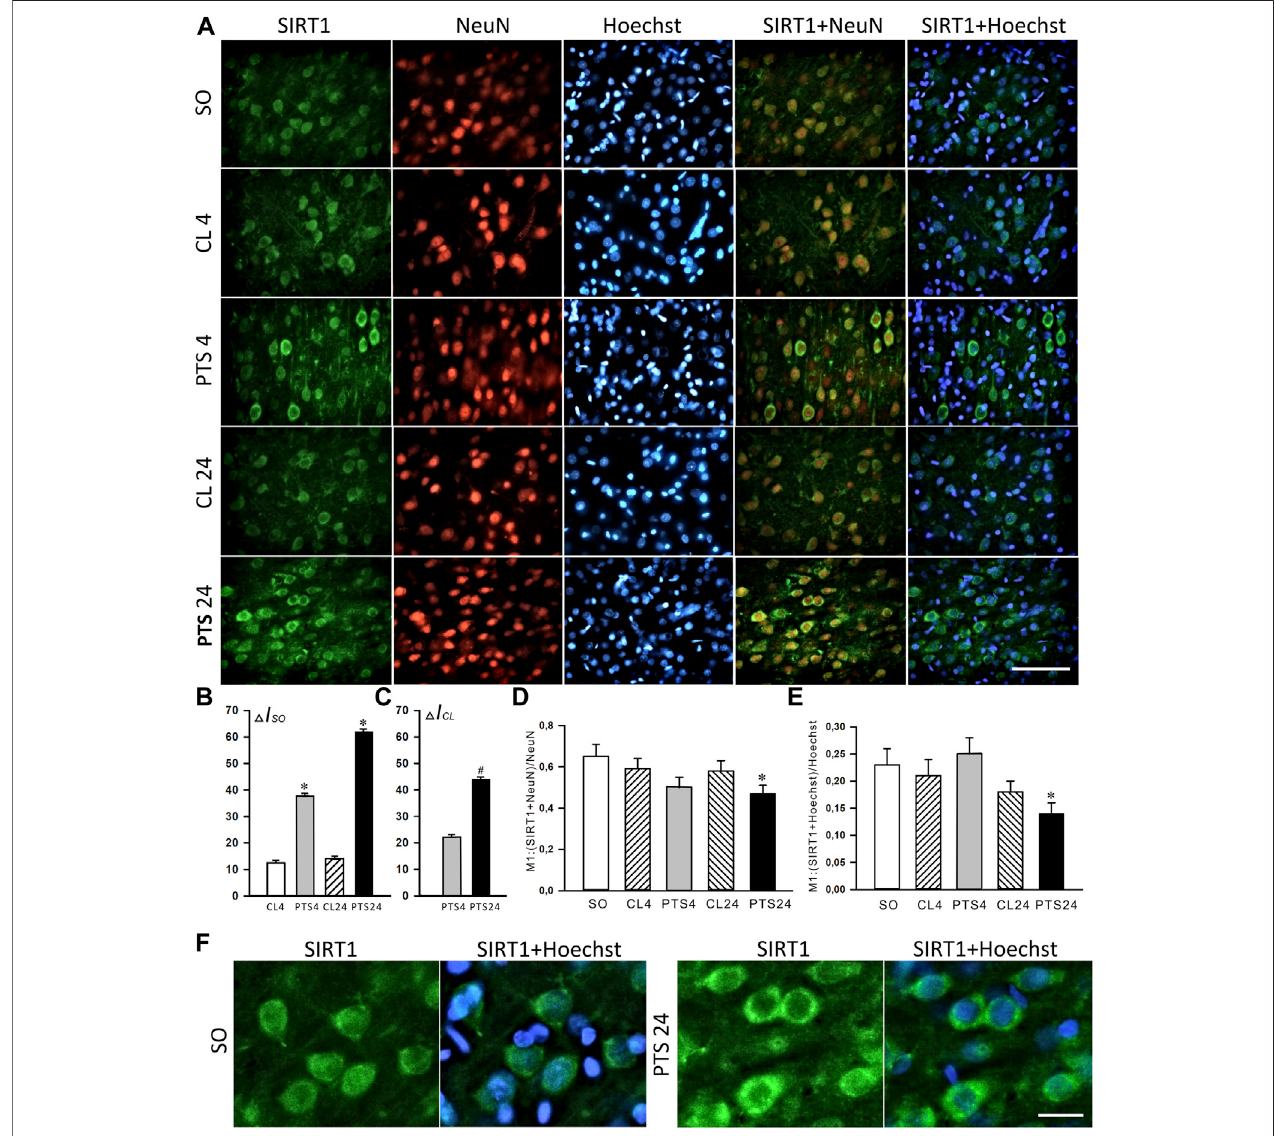
FIGURE2| SIRT1levelsandlocalizationintheneuronsofischemicpenumbra4and24 hafterphotothromboticstrokeintheratcerebralcortex(PTS4andPTS24, respectively) compared to the same animals ’ contralateral cortex (CL4 and CL24), or the cerebral cortex of sham-operated animals (SO). (A) Immuno fl uorescence of SIRT1(green), neuronal markerNeuN(red), nuclearchromatinmarkerHoechst33342 (blue), andimage overlay. Thescalebaris100 μ m. (B) Percentchanges( Δ ISO)of SIRT1 levels in the penumbra (PTS4 or PTS24) and the contralateral hemisphere (CL4 or CL24) compared to the brain cortex of the sham-operated rats (SO) 4 or 24 h after the PTS. (C) Percent changes ( Δ ICL) of SIRT1 levels in the penumbra (PTS4 or PTS24) compared to the contralateral cortex of the same rats 4 or 24 h after PTS. (D) Coef fi cientM1ofSIRT1co-localizationwiththeneuronalmarker(NeuN)indifferentcontrolandexperimentalgroups. (E) Coef fi cientM1ofSIRT1co-localization with the nuclear marker (Hoechst 33342) in different control and experimental groups. (F) Immuno fl uorescence of SIRT1 in the penumbra at bigger magni fi cation (×40). The scale bar is 30 μ m. One Way ANOVA; M ± SEM; n = 7.